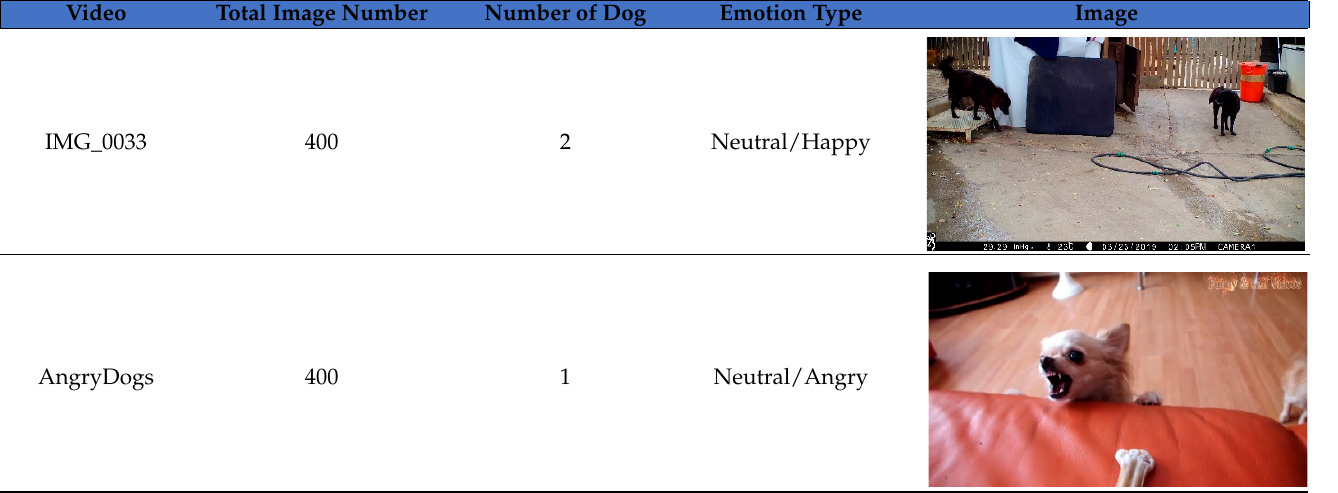
Table 9. Test data-set of integrated system.